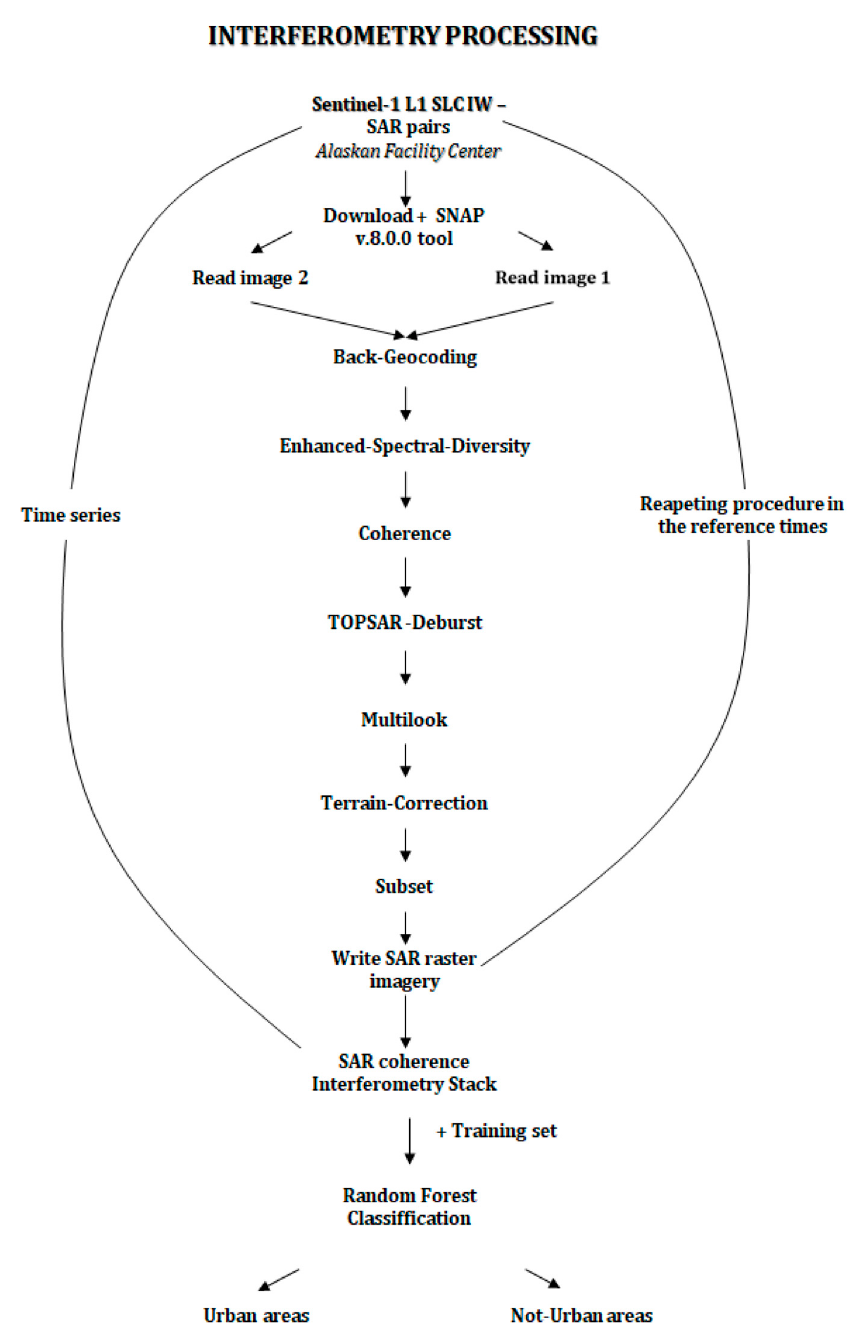
Figure 2. Interferometry and classification in the ESA SNAP tool.